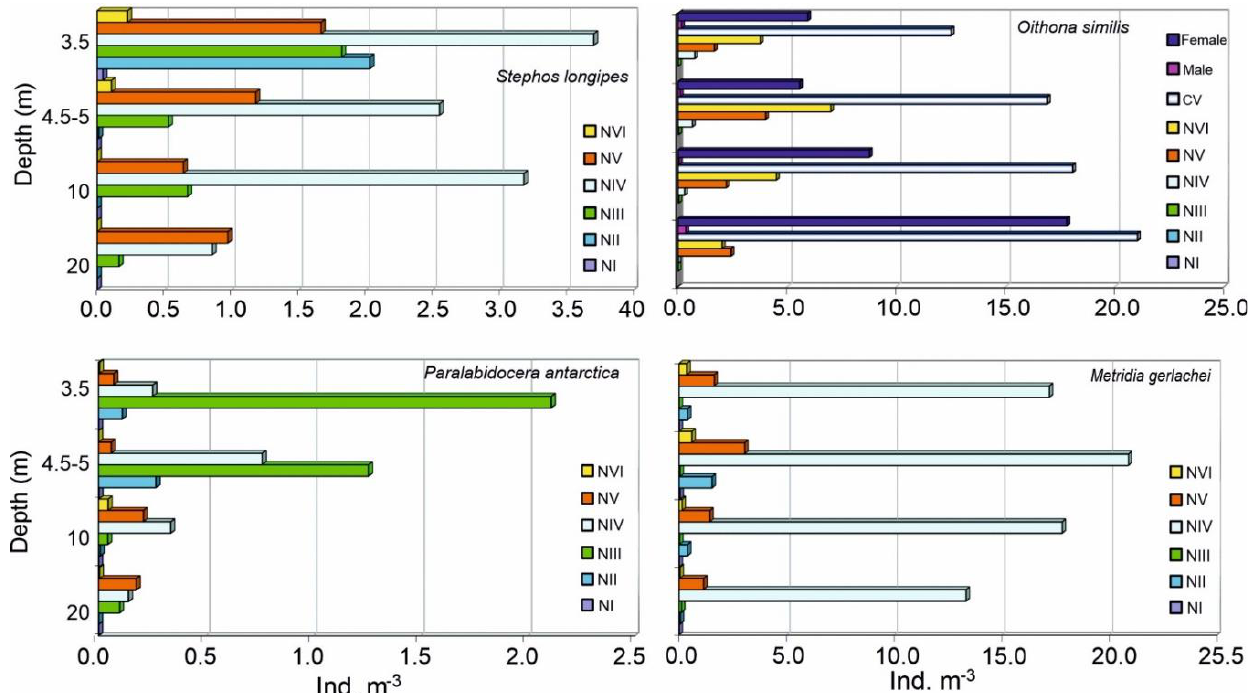
Figure 9. PIPEX 97 cruise, Terra Nova Bay, Antarctica 1997. Average abundance (ind m −3 ) through the top 20 m of the water column of the four most representative adult and development stages of copepod species throughout the sampling period.